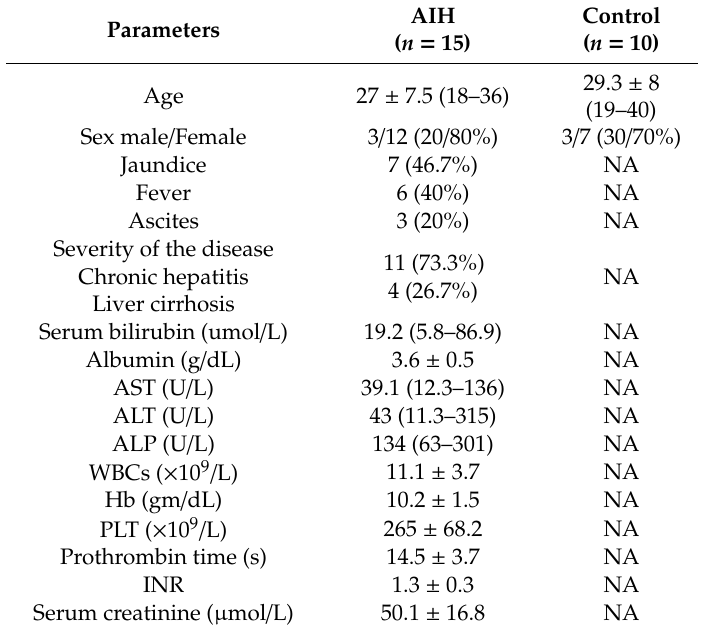
Table 1. Demographic, clinical and laboratory characteristics of the